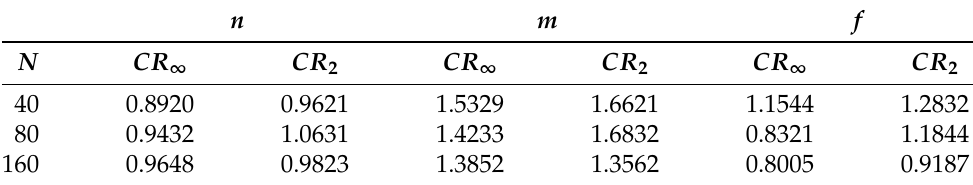
Table 8. Convergence rates of the original problem in different norms, Example